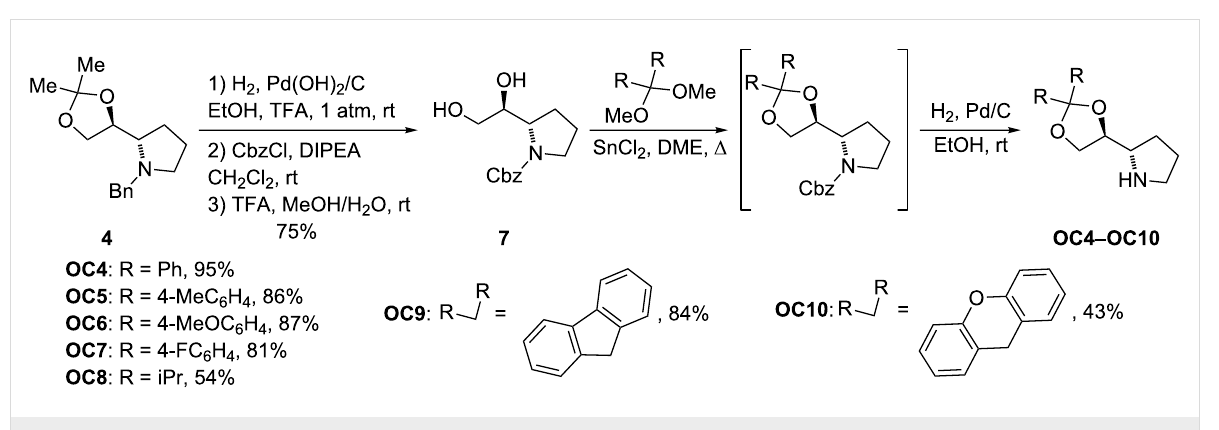
Scheme 4: Synthesis of new organocatalysts OC4 – OC10 .